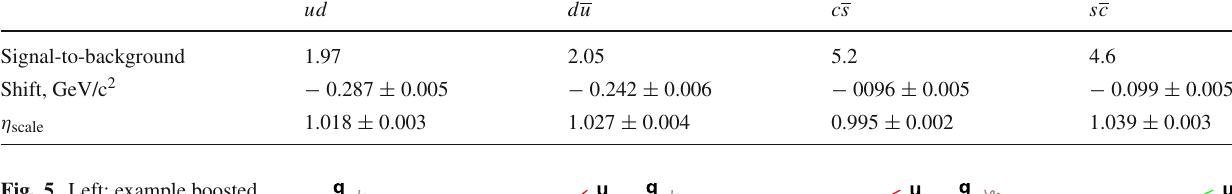
Fig. 5 Left: example boosted W boson plus quark production diagram. Centre and Right: example QCD diagrams leading to the same quark